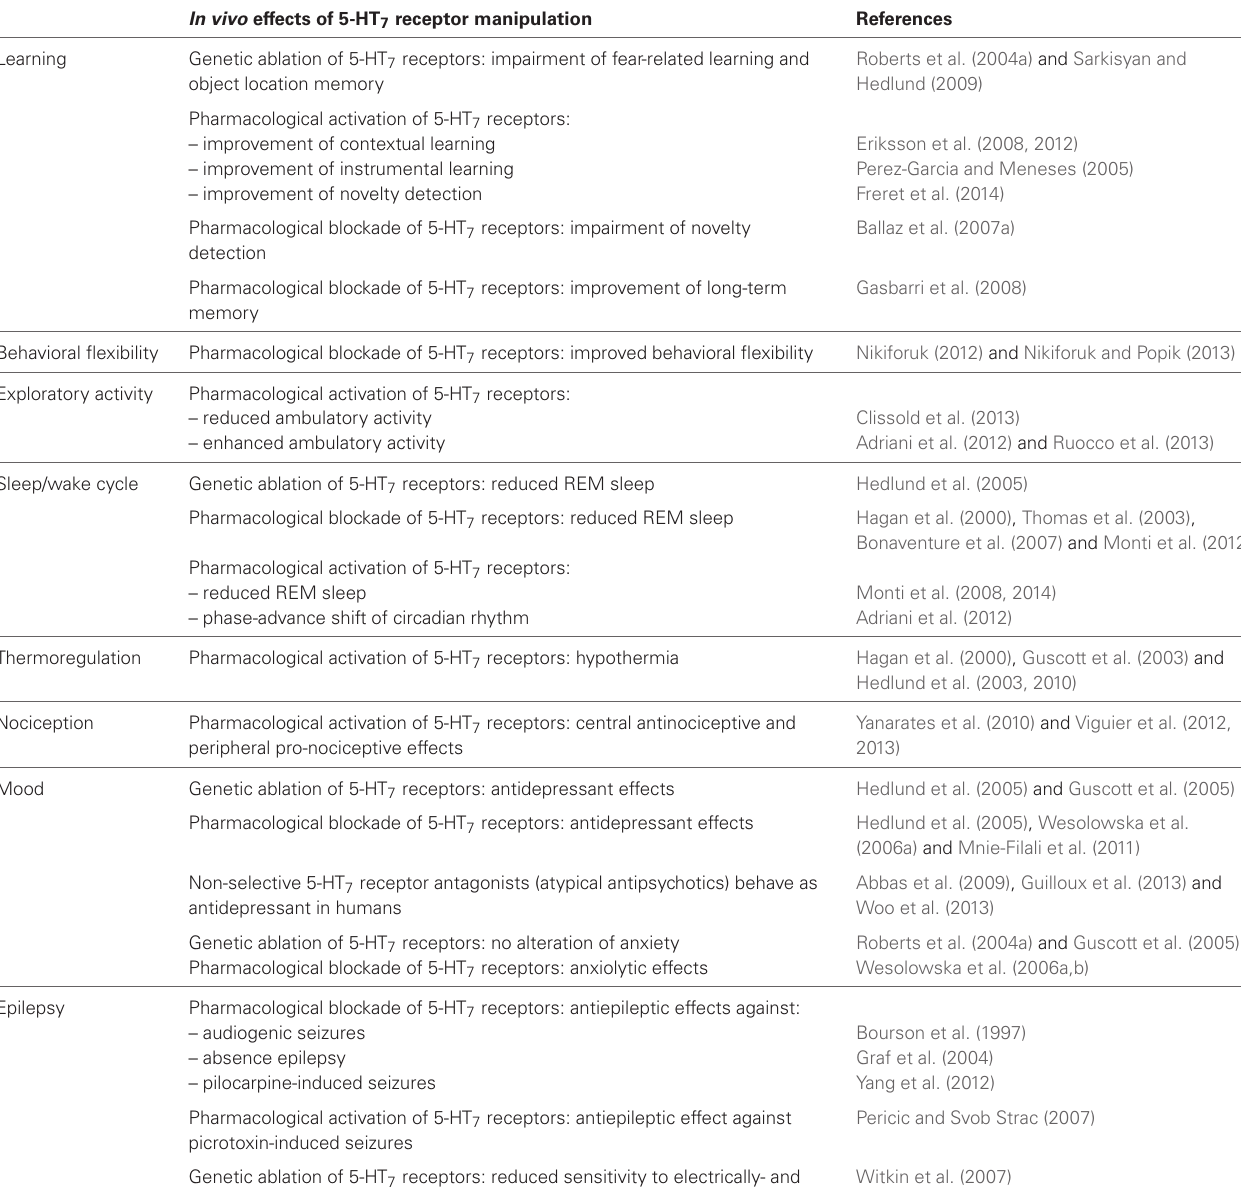
Table 1 | In vivo effects of pharmacological activation, pharmacological blockade or genetic ablation of 5-HT 7 receptors . In vivo effects of 5-HT 7 receptor